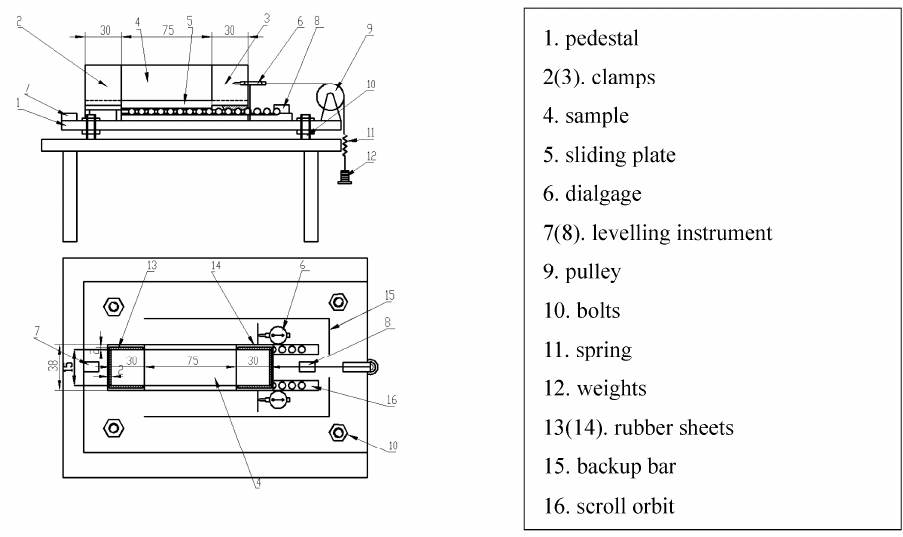
Figure 2. Schematic drawing of the uniaxial direct-tension test apparatus (units for the numbers: mm).